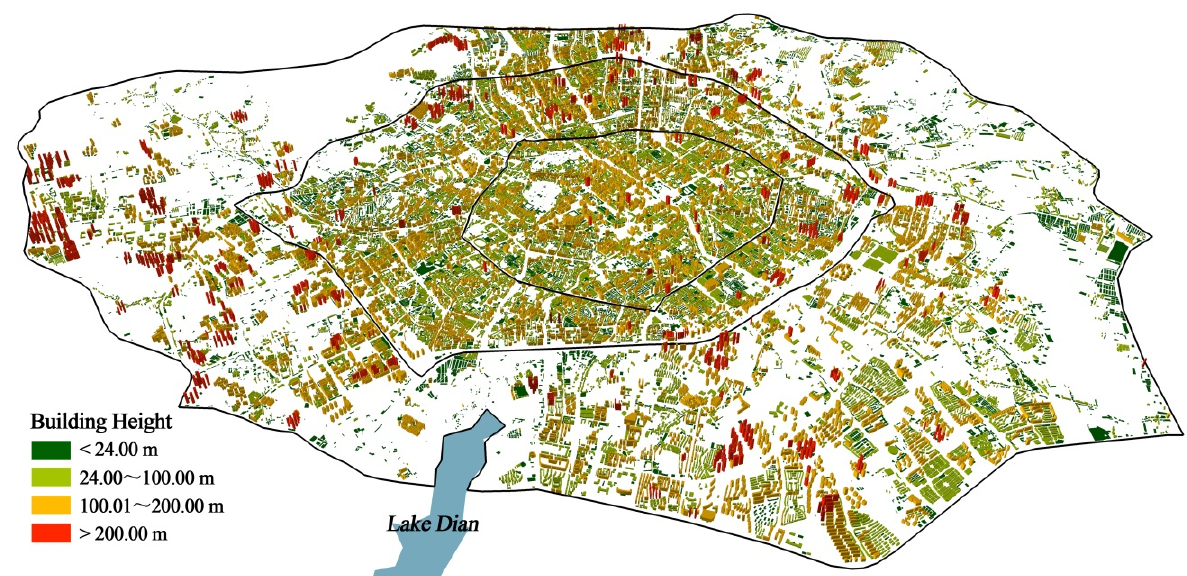
Figure 3. 3D spatial pattern distribution of single buildings in Kunming’s Main Urban District.